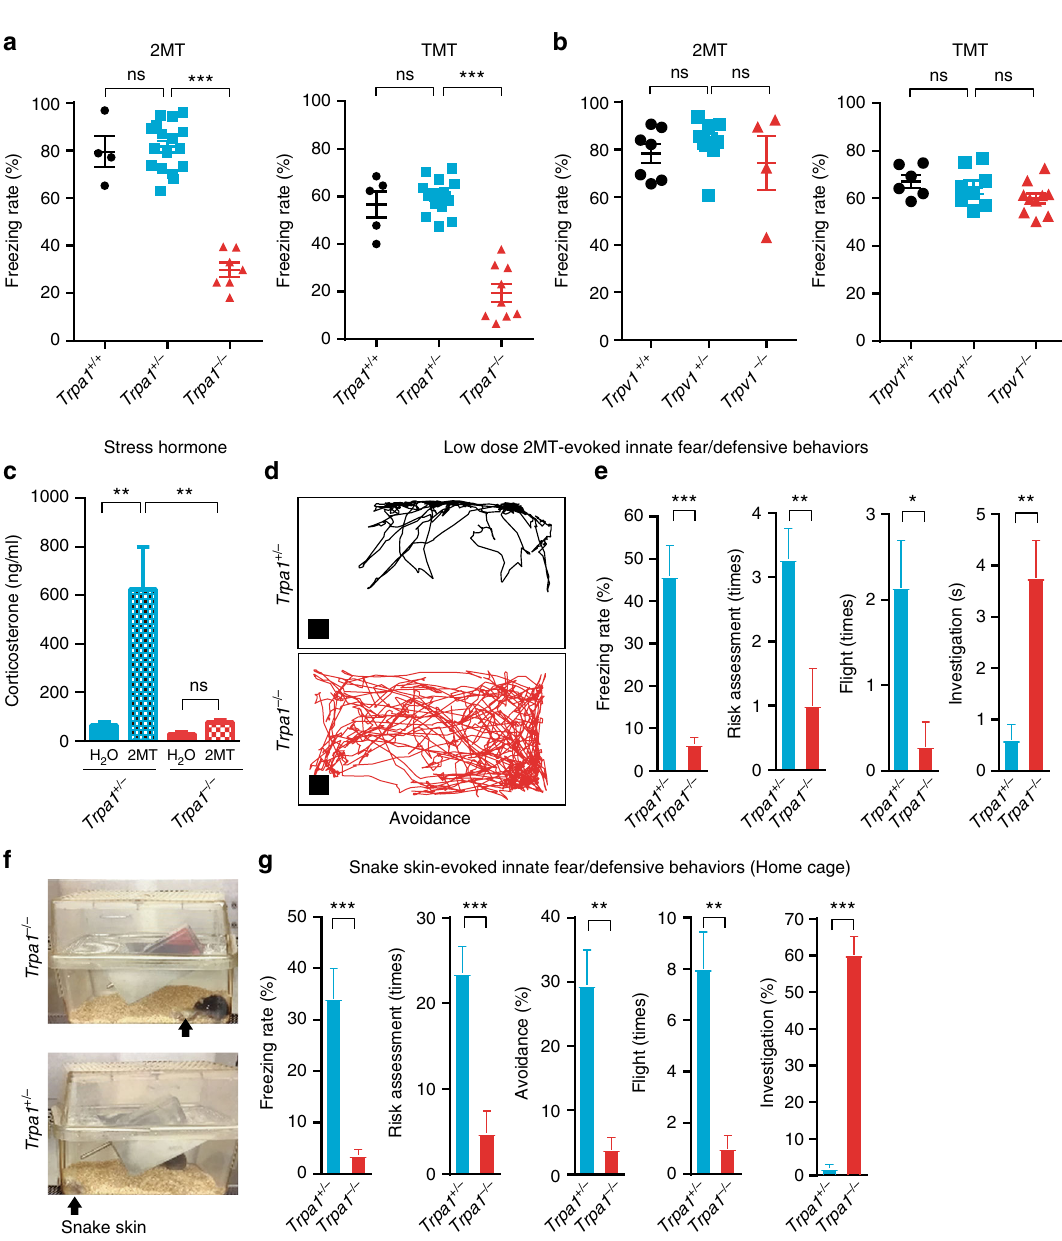
Fig. 3 Trpa1 mediates 2MT/TMT/snake skin-evoked innate fear/defensive responses. a , b Wild-type, heterozygous, and homozygous Trpa1 ( a ) and Trpv1 ( b ) knockout mice were examined for innate freezing behaviors evoked by 2MT or TMT. Data are presented as mean ± SEM (Student ’ s t -test, *** P < 0.001; ** P < 0.01; ns not signi fi cant). c Plasma concentration of stress hormone corticosterone was measured in Trpa1 + / − and Trpa1 − / − mice following exposure to H 2 O or 2MT for 20 min. Data are presented as mean ± SEM ( n = 6, two-way ANOVA test, ** P < 0.01). d Representative avoidance tracks of Trpa1 + / − and Trpa1 − / − mice in response to low concentration (1.05 × 10 − 6 mole) of 2MT exposure in the test cage. The black box indicates the position of 2MT- containing fi lter paper. e Quantitative analysis of freezing, risk assessment, fl ight, and investigation behaviors of Trpa1 + / − and Trpa1 − / − mice in testing cages in response to low-dose 2MT exposure. Data are presented as mean ± SEM ( n = 7, Student ’ s t -test, *** P < 0.001; ** P < 0.01, * P < 0.05). f An image depicting the snake skin-evoked innate fear assay in the home cage. g Quantitative analysis of snake skin-evoked freezing, risk assessment, avoidance, fl ight, and investigation behaviors of Trpa1 + / − and Trpa1 − / − mice. Data are presented as mean ± SEM ( n = 6, Student ’ s t -test, *** P < 0.001; ** P <